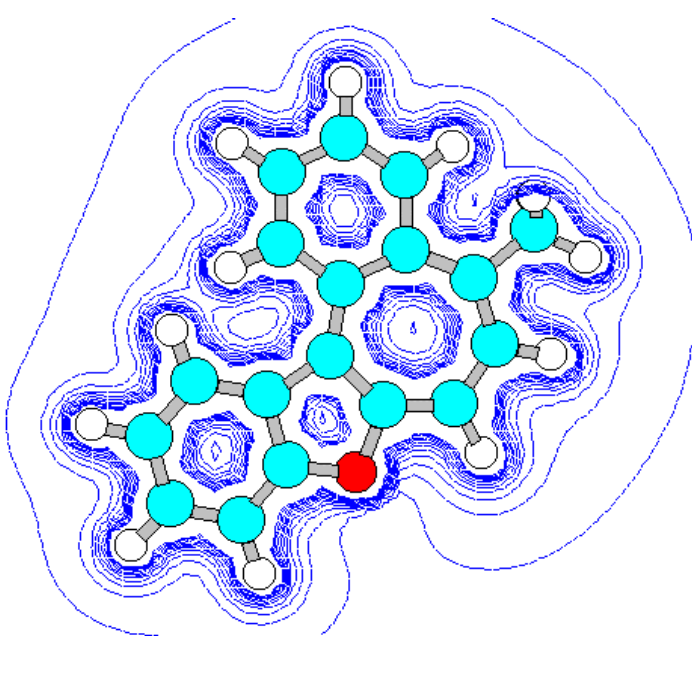
Figure 3. Energy minimized structure (AM1) of hypotetic cation C generated by HyperChem 5.0 pro- gram (with 2Dcontour map of electrostatic